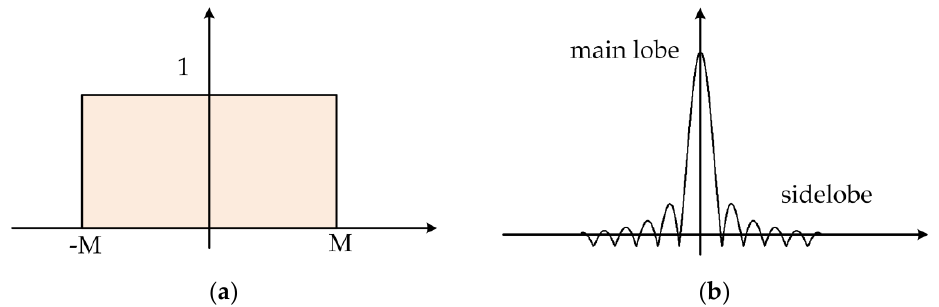
Figure 1. ( a ) Time-domain diagram of a rectangular window function; ( b ) spectrum diagram of a rectangular window function.